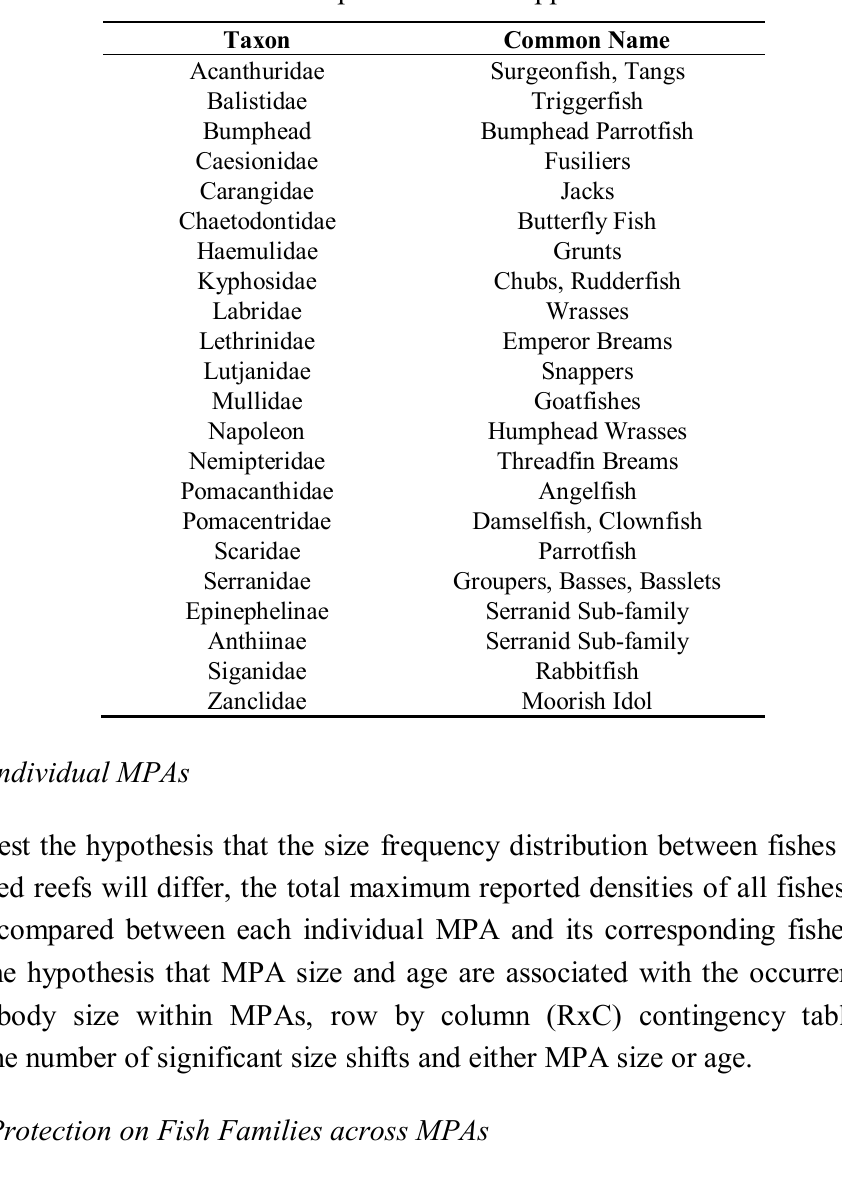
Table 1. The list of all fish families and sub-families included in the fish visual censuses conducted at all 23 MPAs/fished reef pairs in the